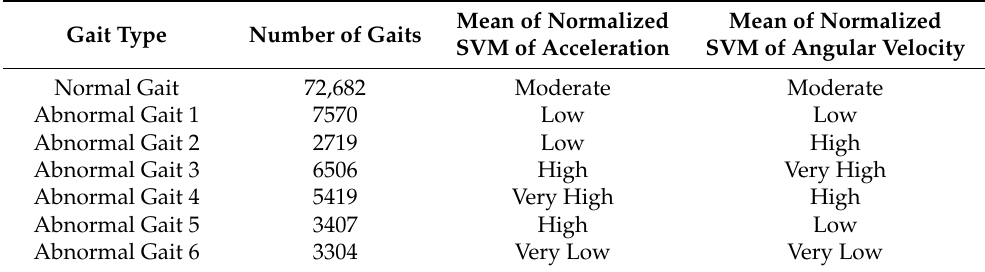
Table 3. Characteristics of classified normal gaits and six types of abnormal gait in terms of accelerom- eter and gyroscope